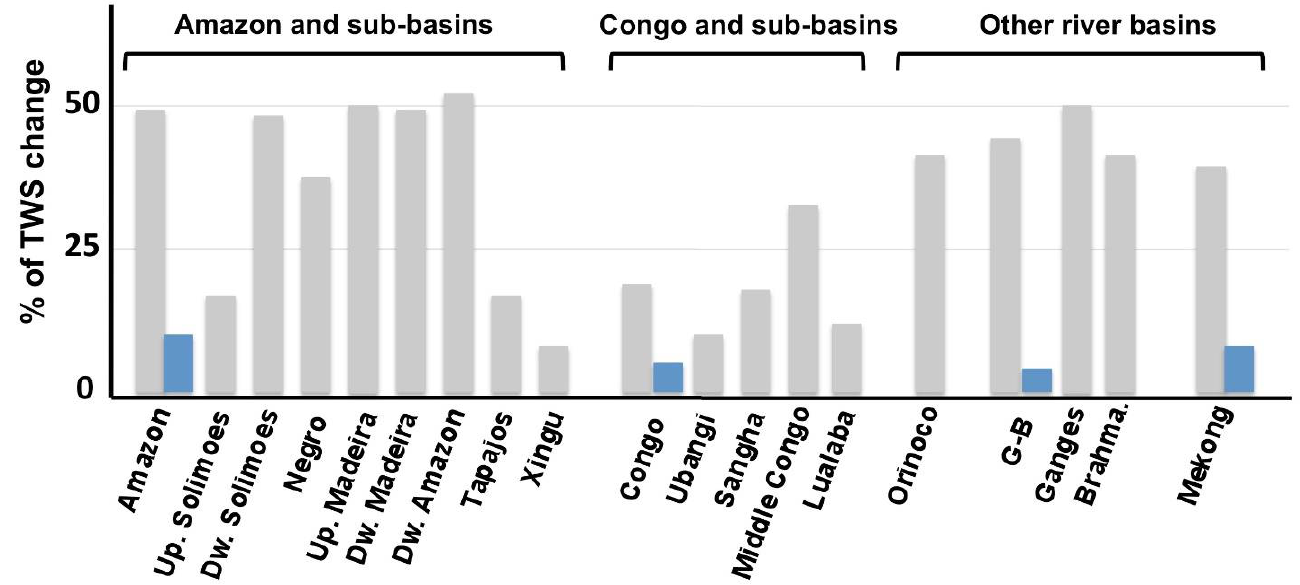
Figure 6. The relative contributions of surface water storage (SWS) to total water storage (TWS) from GRACE for several river basins worldwide from the various estimates discussed in the present review. The gray bars are from various satellite-based estimates, and the blue bars are from model outputs.